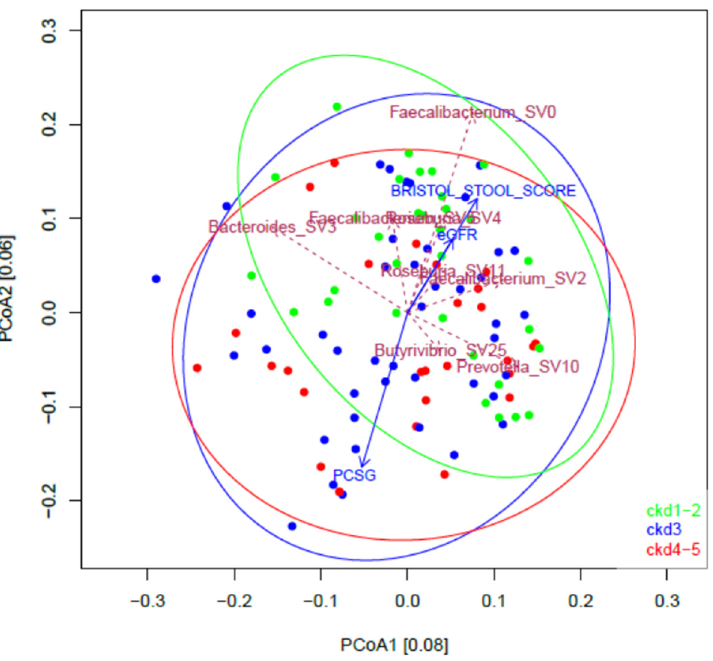
Figure 2. Principal coordinate analysis of the microbial composition of the fecal samples of patients with CKD. Colors and ellipses are coding for CKD stages; SV: (amplicon) sequencing variant; PCSG: p -cresyl sulfate + p -cresyl glucuronide; eGFR: estimated glomerular filtration rate. The correlation between plasma levels of intestinally generated uremic toxins and transit time was assessed by analyzing their correlation with BSS [1 (severe constipation) 1